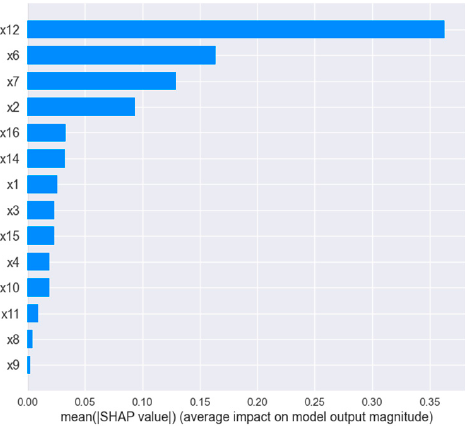
Figure 10. Importance of each feature.